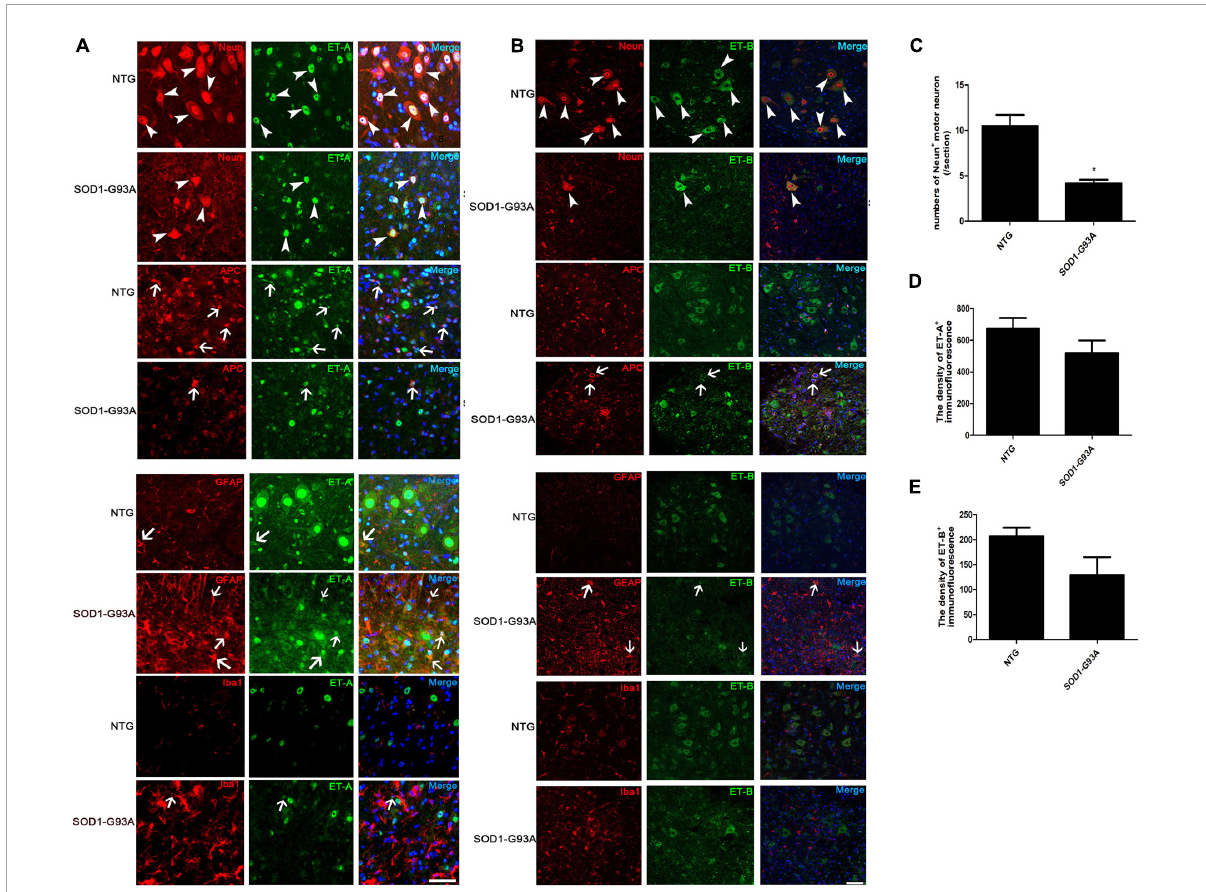
FIGURE2 Cellular localization of ET-A and ET-B in the lumbar spinal cord of non-transgenic (NTG) mice and SOD1-G93A transgenic mice at end stage. (A,B) are photographed by Olympus FV1000 confocal microscopy, (C,D) are photographed by Zeiss Vert. A1, German confocal microscopy. (A) Colocalization of ET-A (green) with NeuN (red) in MNs and APC (red) in mature oligodendrocytes of NTG and SOD1-G93A mice; ET-A (green) colocalization with GFAP (red) in astrocytes and Iba1 (red) in microglia of NTG and SOD1-G93A mice. (B) Colocalization of ET-B (green) with NeuN (red) in MNs and APC (red) in mature oligodendrocytes of NTG and SOD1-G93A mice; ET-B (green) colocalization with GFAP (red) in astrocytes and Iba1 (red) in microglia, respectively, in the lumbar spinal cord of NTG and SOD1-G93A mice. (C–E) The statistical analysis of NeuN + motor neuron numbers, and the fluorescence intensity of ET-A, ET-B in the NeuN/ET-A or NeuN/ET-B co-labeled sections. Data represent the mean ± SEM, statistical significance was assessed by Unpaired t -test. *P < 0.05. The arrows indicate glial cells, and the arrowheads indicate neurons. Bar = 50 µ